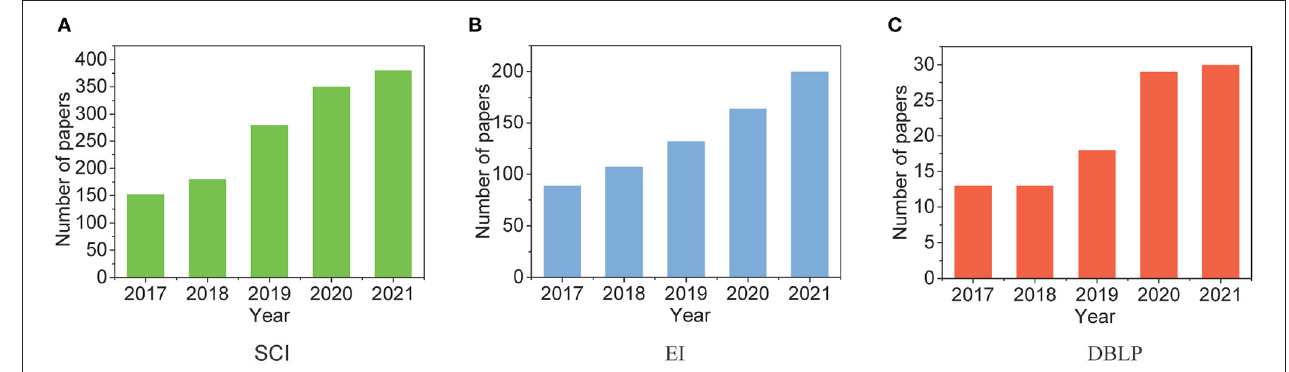
FIGURE 1 | Changes in the number of papers related to fake reviews in the past 5 years. (A) SCI. (B) EI. (C)